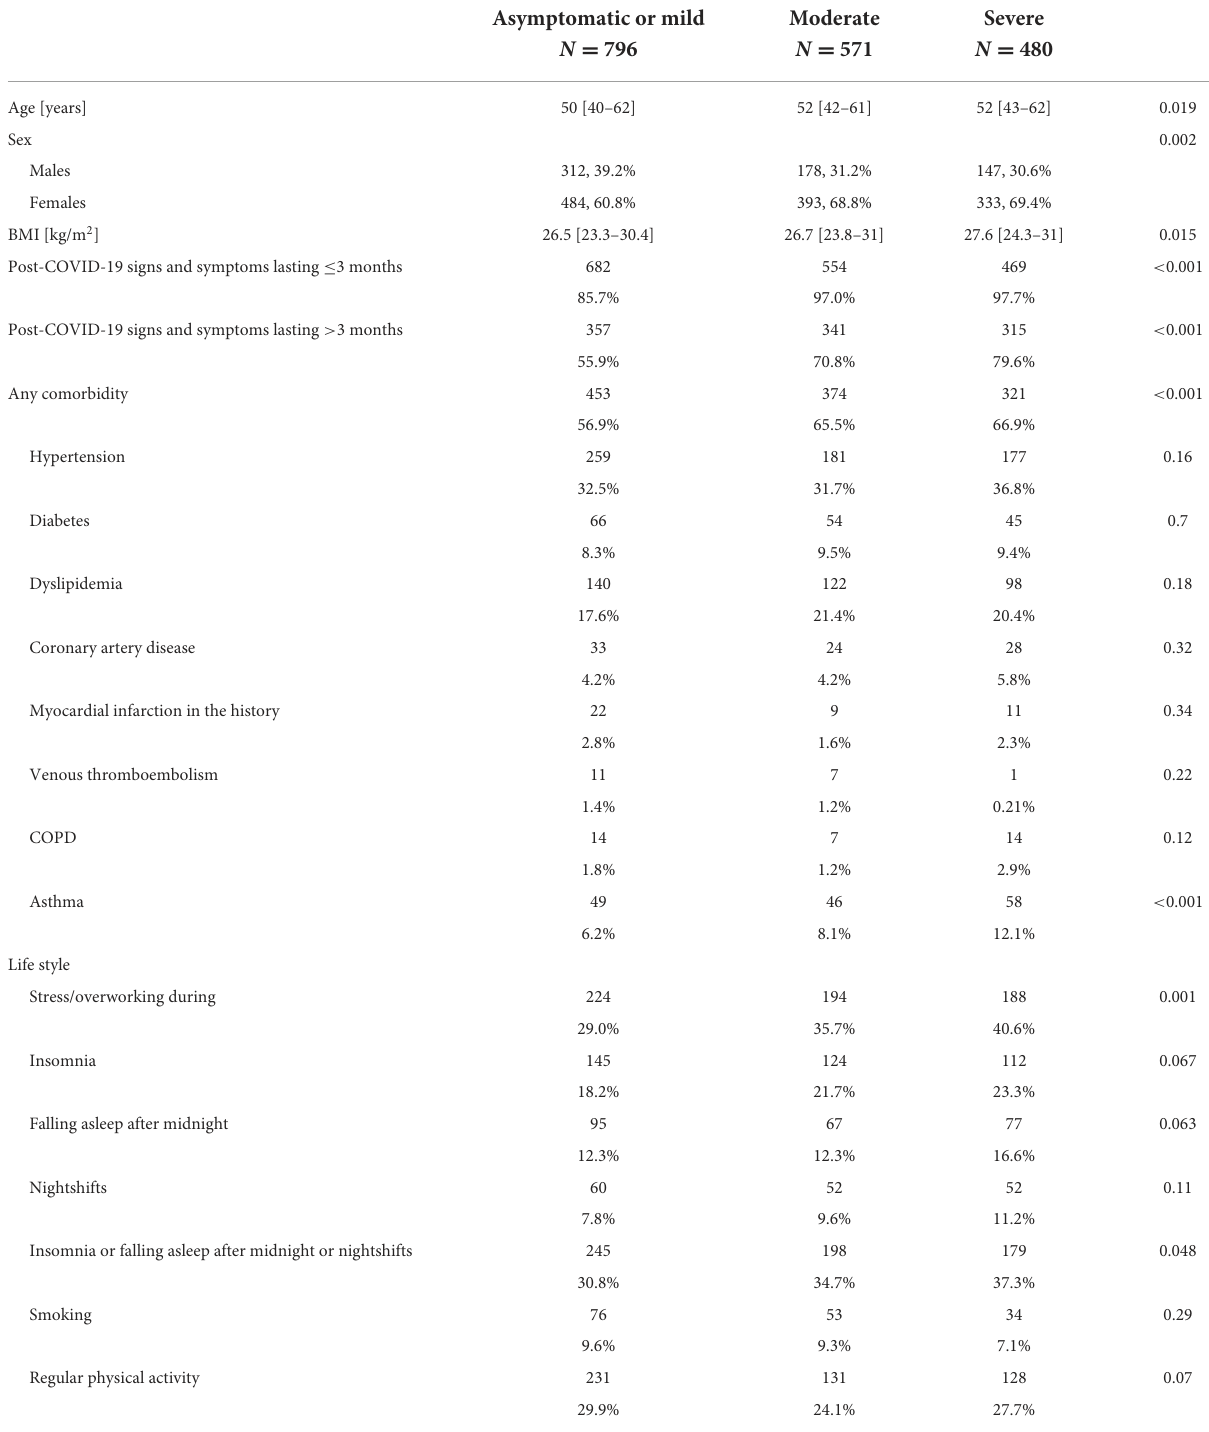
TABLE 1 The study group characteristics with regard to the course of the acute phase of the COVID-19